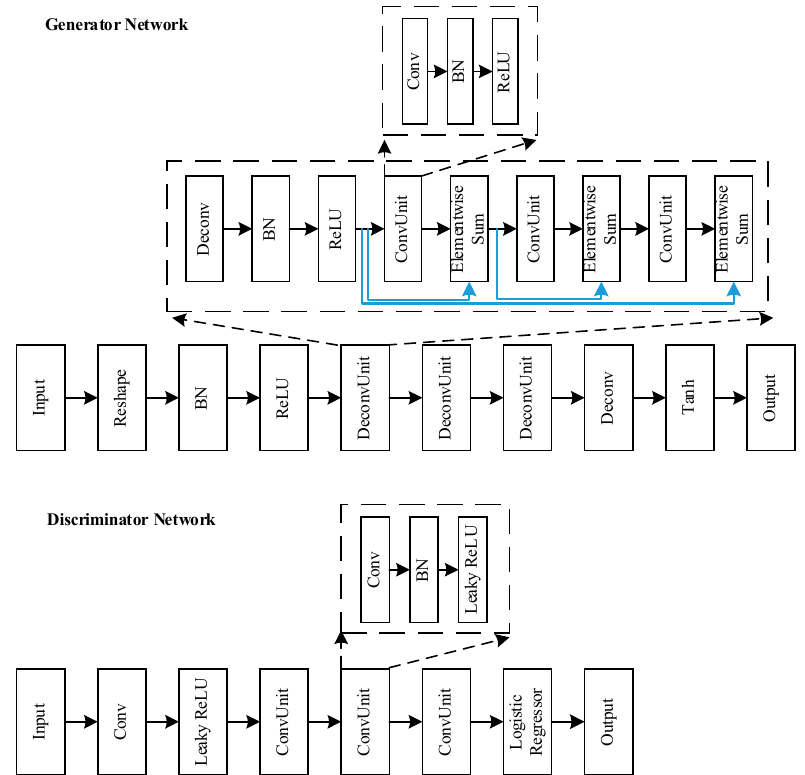
Figure 1. Generative adversarial network (GAN) structure. The whole structure consists of a generator network and a discriminator network. The generator consists of three DeconvUnits and the discriminator has three ConvUnits. The output of the generator is the input of the